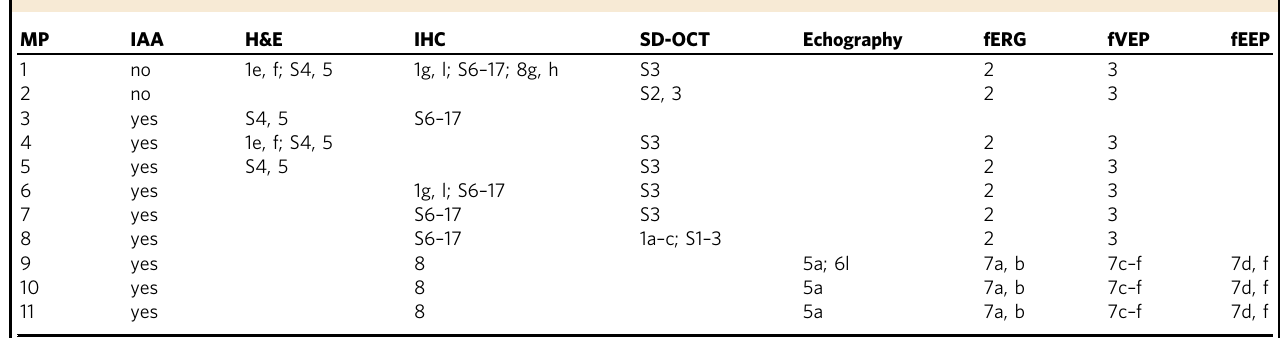
Table 1 List of Göttingen minipigs used in the